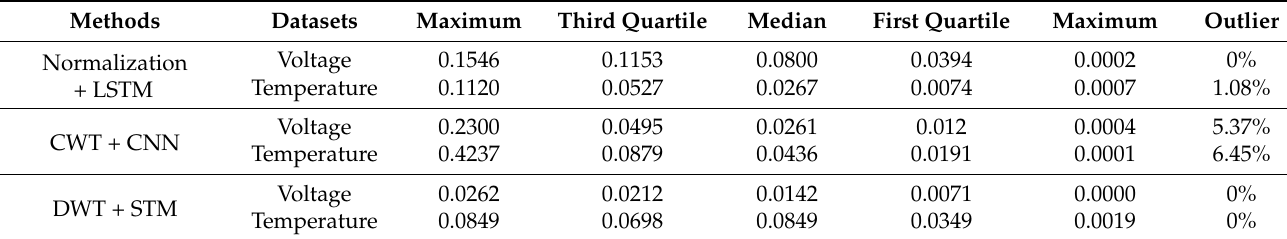
Table 6. Relative error of different